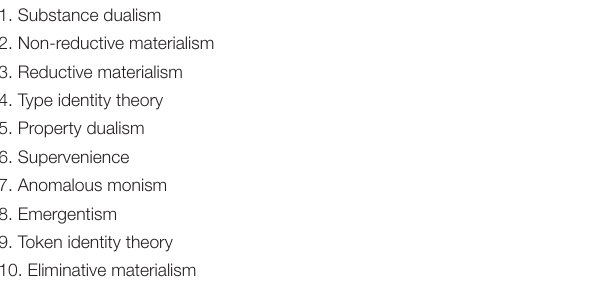
TABLE 4 | The order of theories in the Mind-Body Questionnaire.